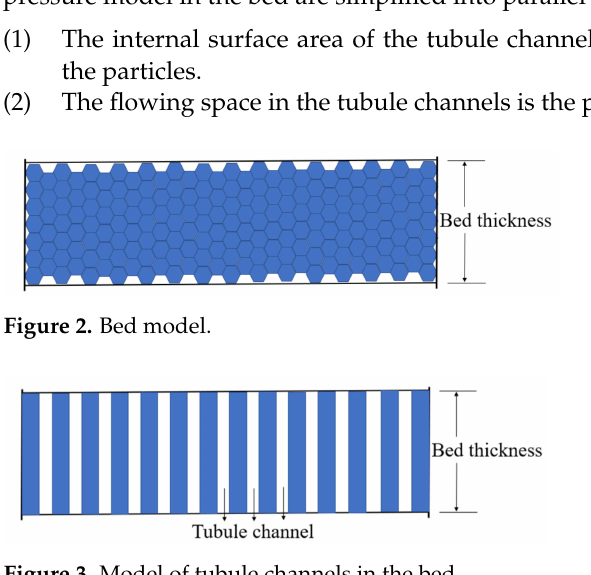
Figure 3. Model of tubule channels in the